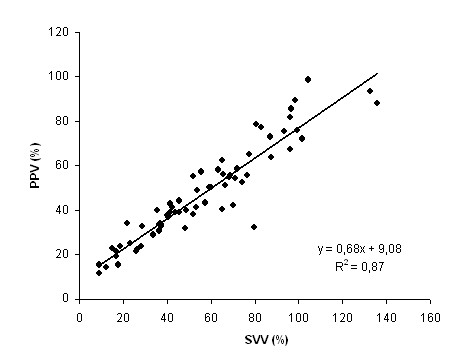
Relation between PPV and SVV. Definition of abbreviations: PPV, pulse pressure variation; SVV, stroke volume variation. The data were pooled from the different steps of the protocol (n = 67).